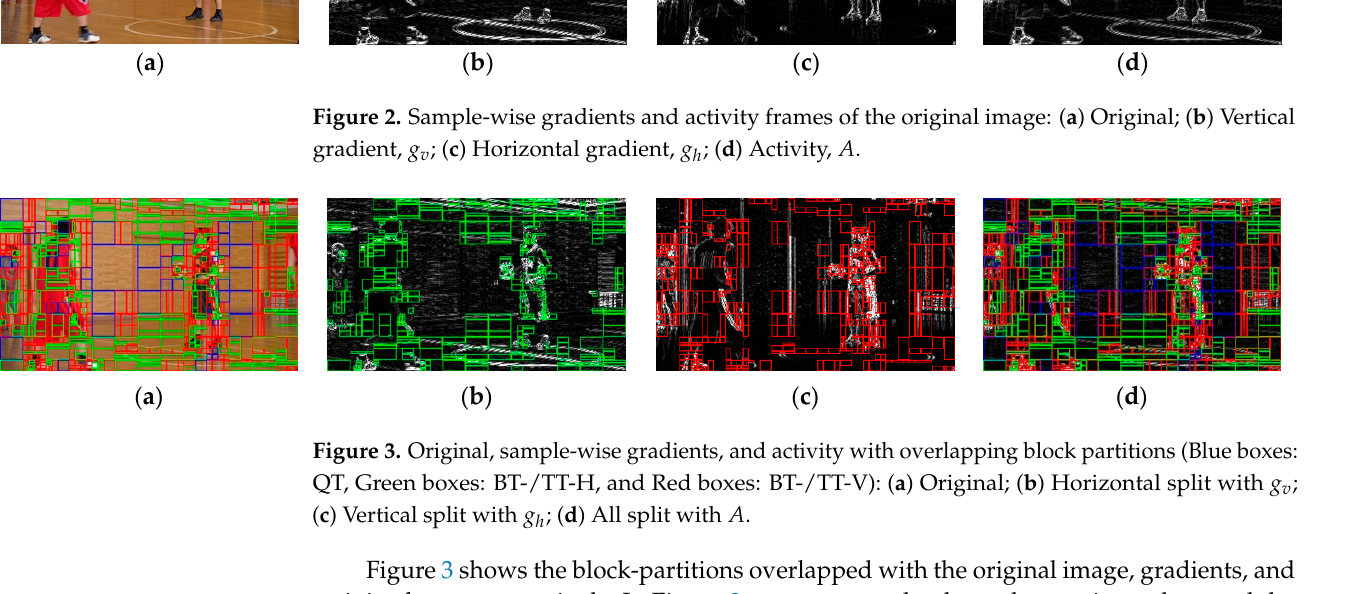
( d ) Figure 4. The activity distribution per sample according to the block size: ( a ) BasketballDrill —832 × 480; ( b ) BasketballDrive —1920 × 1080; ( c ) BQTerrace —1920 × 1080; ( d ) RaceHorsesC —832 × 480. Figure 5 shows the cumulative probability function of activity (CDFA) as a function of QP for various sequences. As shown in Figure 5, the CDFAs of each sequence are almost similar according to QP, and the average activity of a specific CDFA value is barely changed by QP, as shown in Figure 6. This could mean that 𝐴 (cid:3046) does not depend on the QP and can represent the complexity of the current block. In addition, the degree of fast partitioning can be controlled by adjusting the activity threshold according to the CDFA